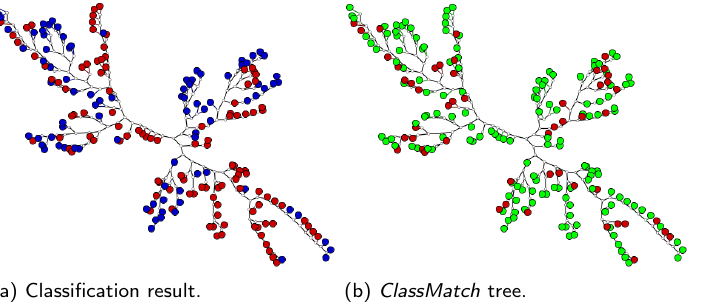
Figure 8. Classification result in the Bag Space Layout of MILTree for the People Category of the Corel-1000 dataset using a classification model with new instance prototypes ( a ) and corresponding classMatch tree ( b